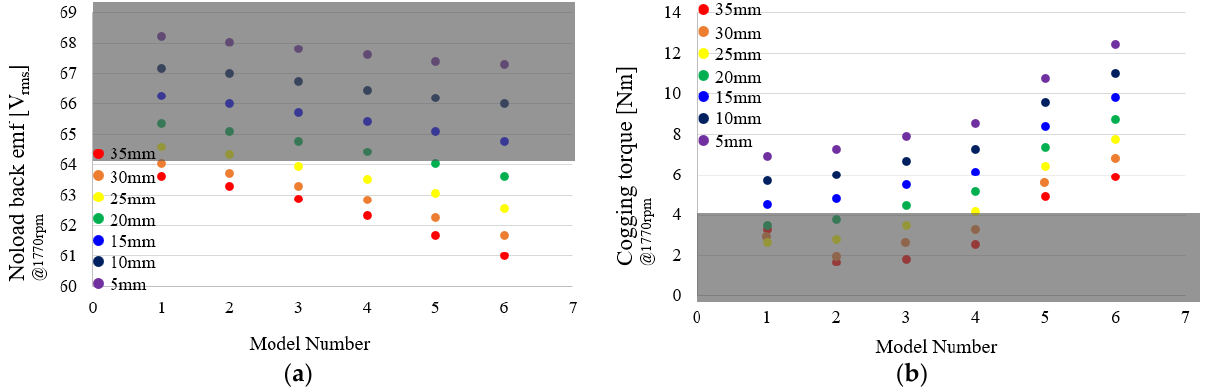
Figure 12. Back emf and cogging torque depending on L tap and tapering skew angle: ( a ) back emf; ( b ) cogging torque.